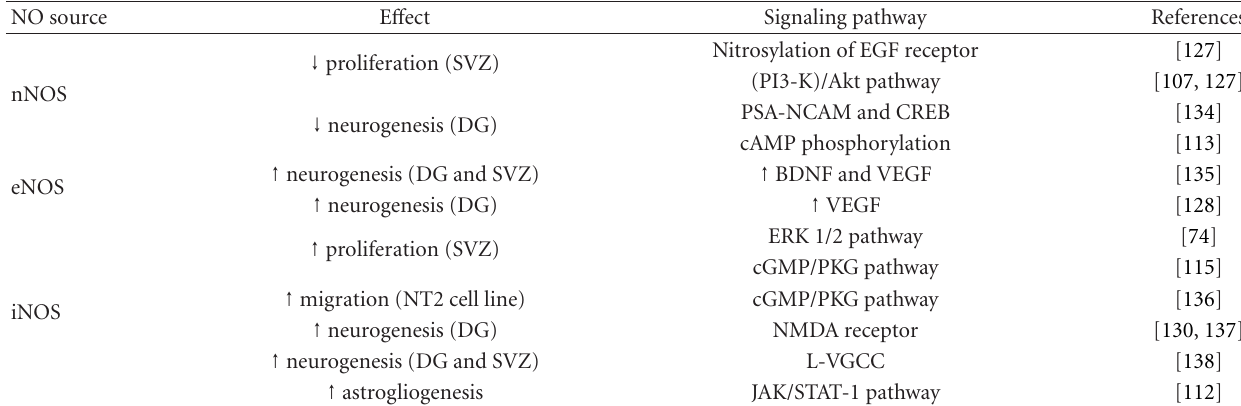
Table 3: NO-dependent signal pathways in